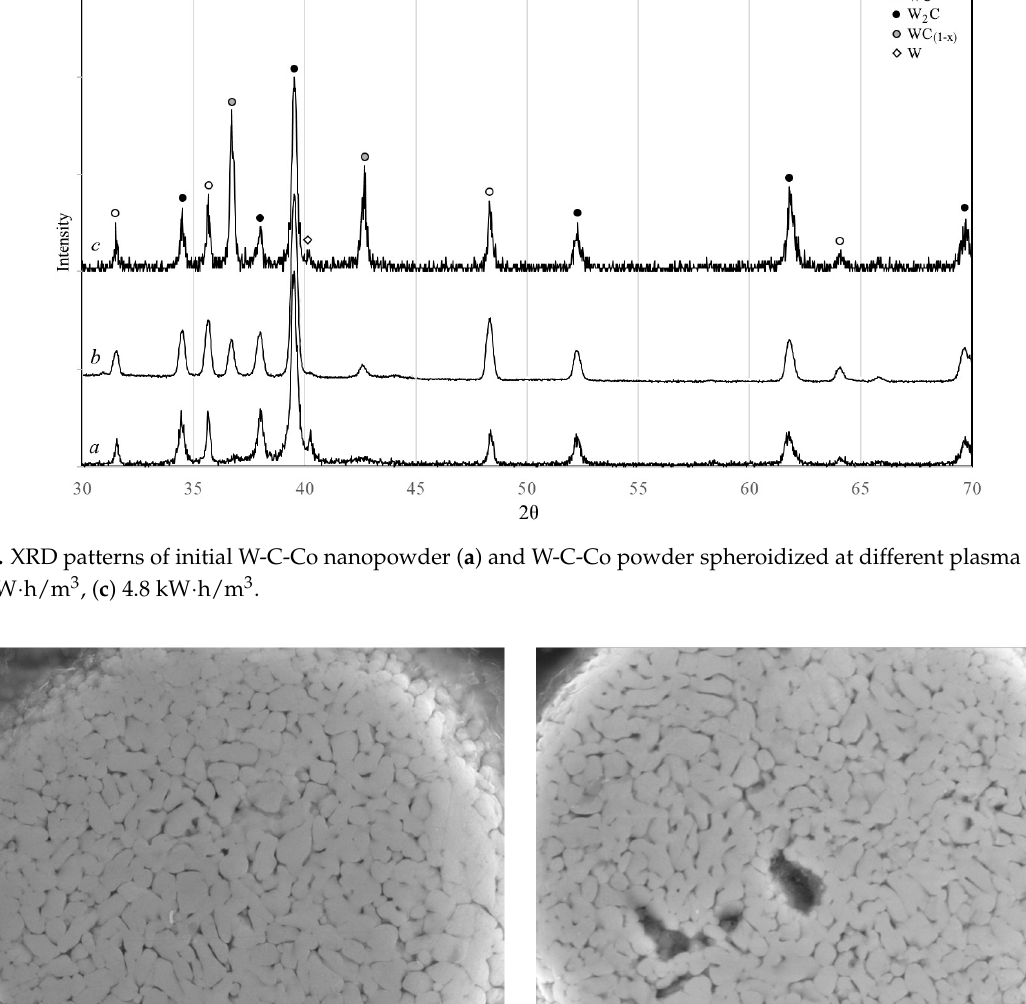
Figure 8. XRD patterns of initial W-C-Co nanopowder ( a ) and W-C-Co powder spheroidized at dif- ferent plasma enthalpy: ( b ) 2.8 kW ∙ h/m 3 , ( c ) 4.8 kW ∙ h/m 3 .